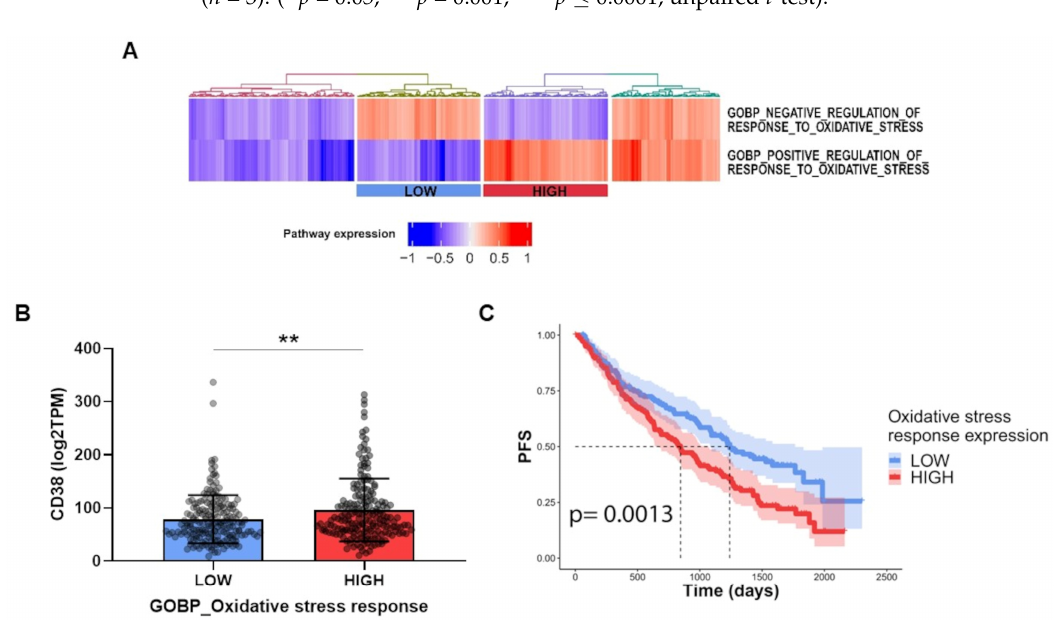
Figure 8. The oxidative stress triggered by energetic depletion is crucial for tested drugs combination. Mitochondrial superoxide anions were detected by immunofluorescence ( A ) and flow cytometry ( B ) using MitoSOX, in H929 cells lentivirally transduced with pLVempty vector or pLV CD38 OE. ( C ) Oxidative stress marker (MDA) and activities of antioxidant enzymes (Catalase, Glutathione reductase-GR) were measured in control and CD38 OE cells. Data are presented as mean ± S.D ( n = 3). (* p = 0.05, *** p = 0.001, **** p ≤ 0.0001; unpaired t -test).